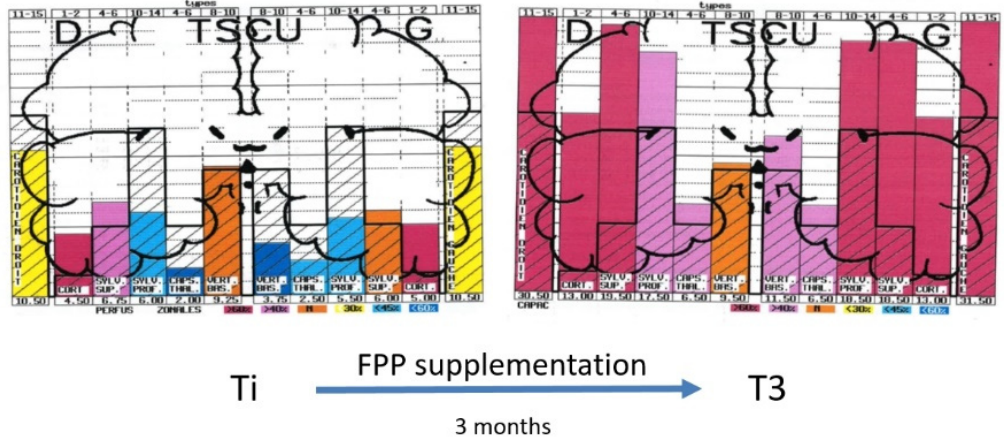
Figure 5. Example of diagrams obtained from the database by using UCTS exploring the global centimetric ultrasound pulsatility in the two temporal lobes of an EHS subject at inclusion (Ti) and three months later (T3) after fermented papaya preparation (FPP) supplementation (9 g per day in two divided doses), according to Reference [33].